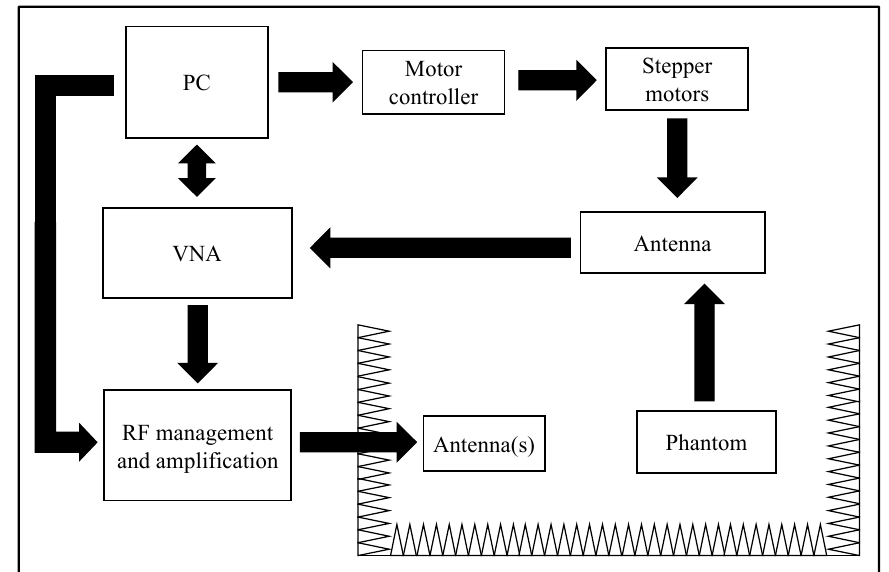
Figure 10. Experimental setup for power measurement inside a liquid phantom.